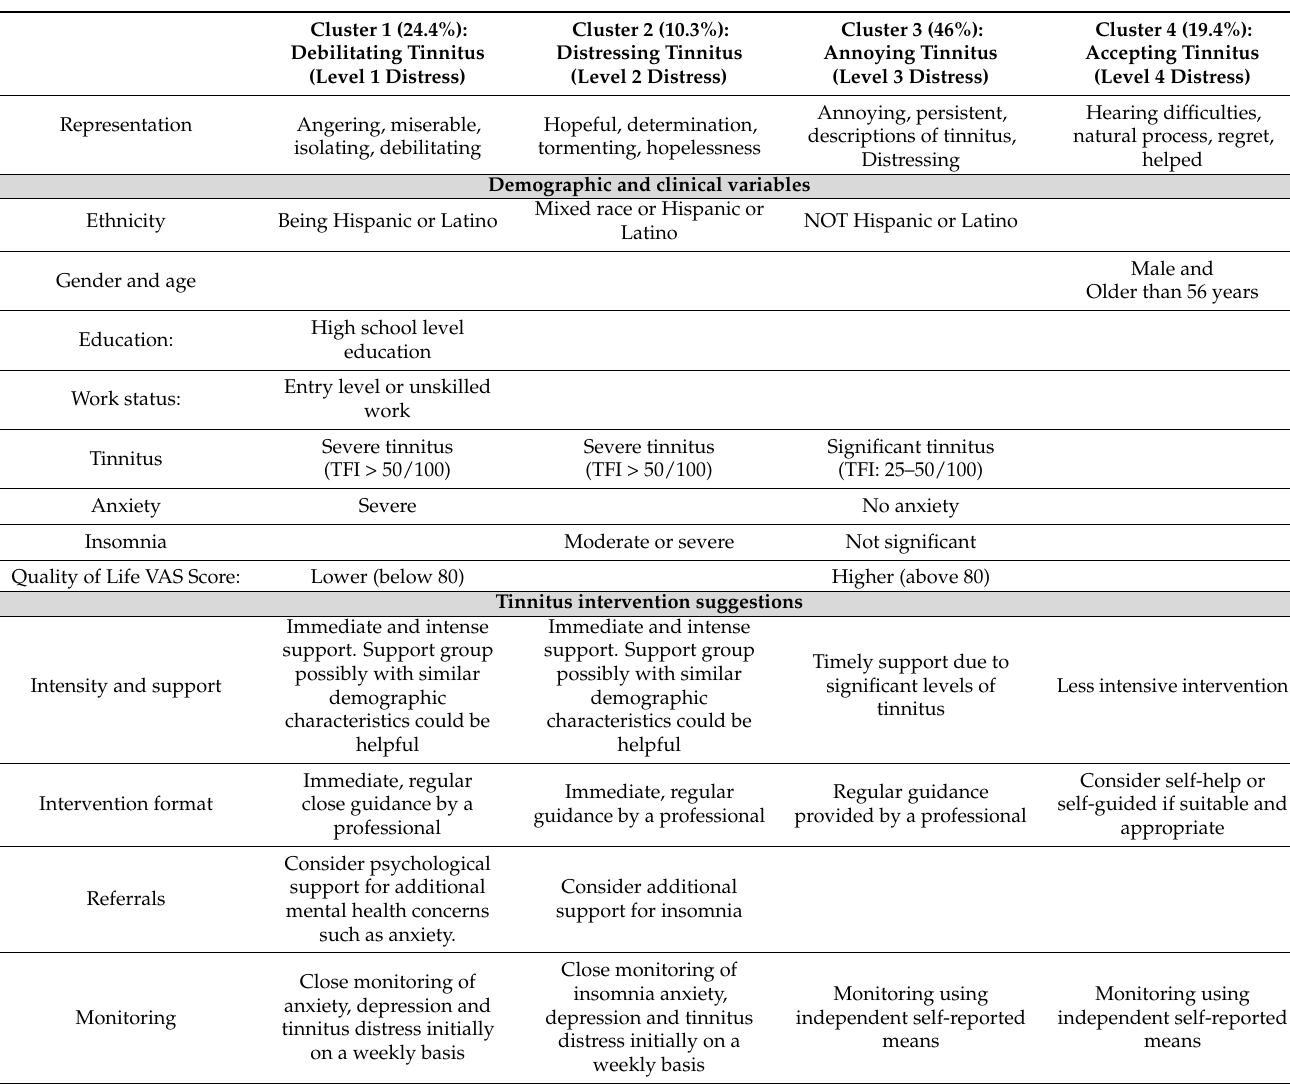
Table 4. Summary of the characteristics for each subgroup and suggested intervention guidelines based on these